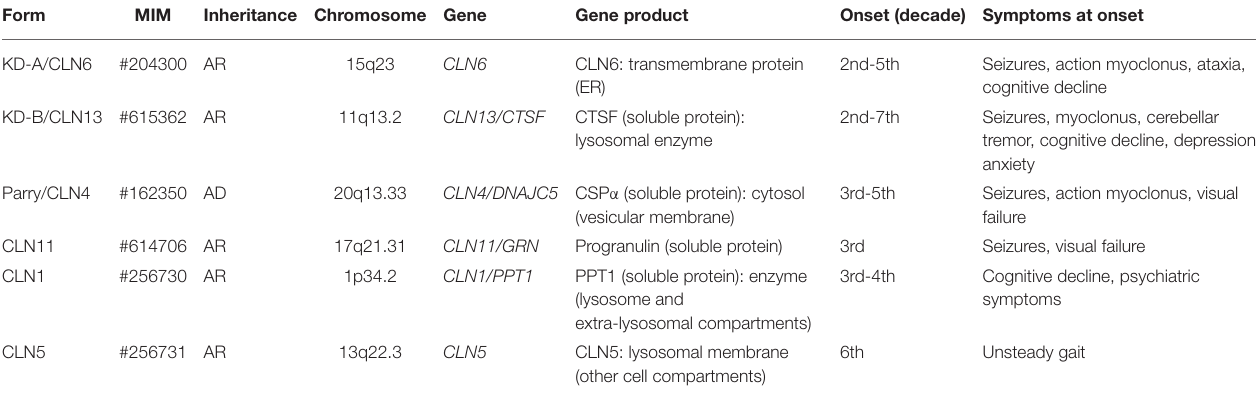
TABLE 2 | Characterization of adult onset